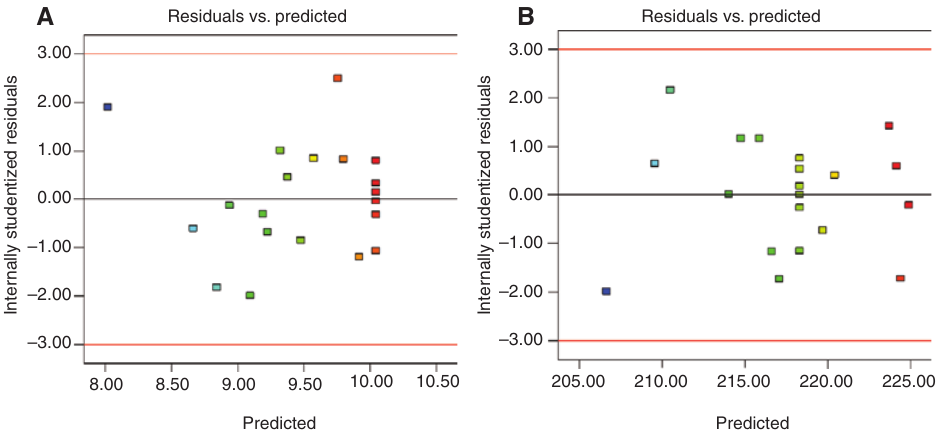
Figure 2: Plot of the residuals vs. the predicted response for the separation factor (A) and the permeation flux